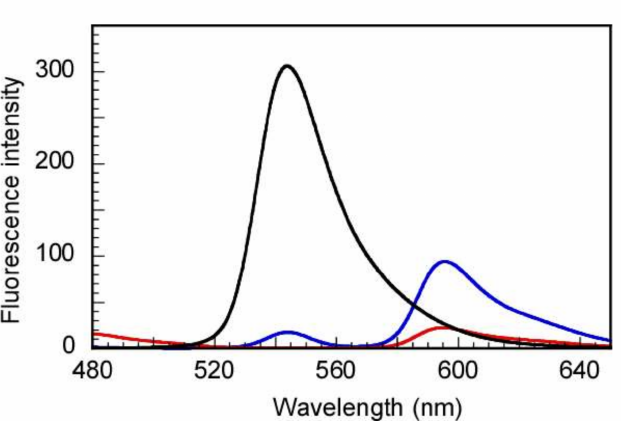
Figure 8. Fluorescence spectra of A488-labeled block polymer (black), A555-labeled random polymer (red), and their equimolar mixture (blue) in acidified dimethylsulfoxide; λ ex = 450 nm, the excitation and emission slit widths were 20 and 1.0 nm, respectively. A488 = Alexa Fluor 488 C5 maleimide; A555 = Alexa Fluor 555 C2